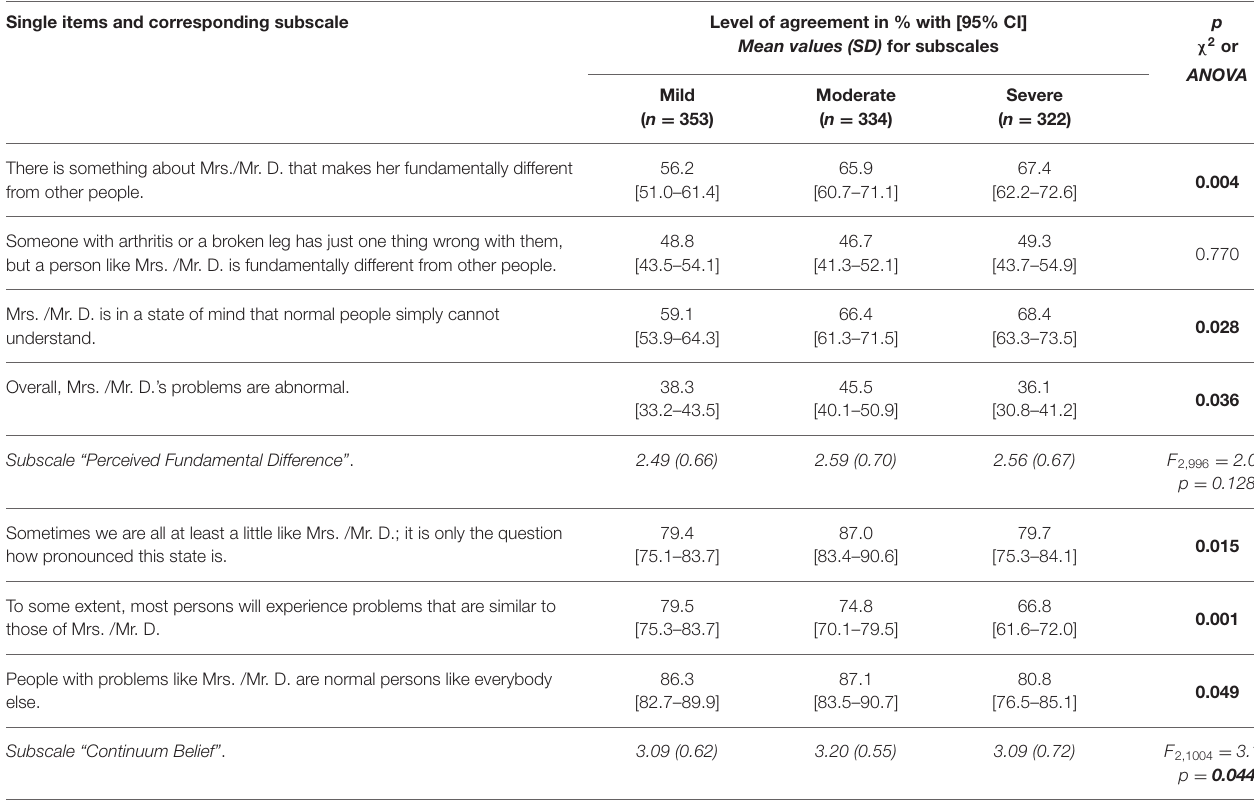
TABLE 2 | Agreement (in %) to single items of the continuum of depression and mean values and [standard deviation (SD)] for subscales ( χ 2 -test for categorical, F -test for mean differences, data weighted, N = 1,009). Single items and corresponding subscale Level of agreement in % with [95% CI]